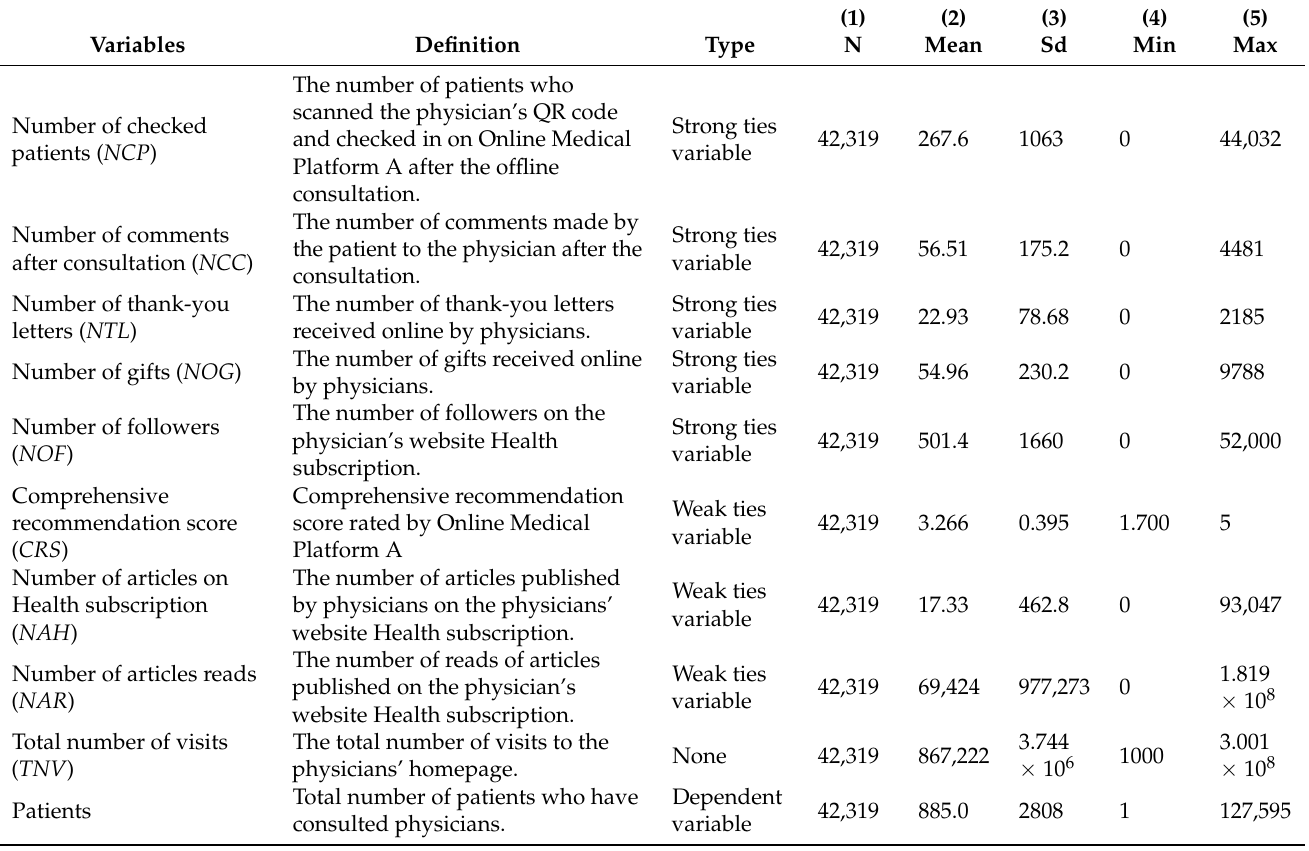
Table 1. Definitions and descriptive statistics of all original